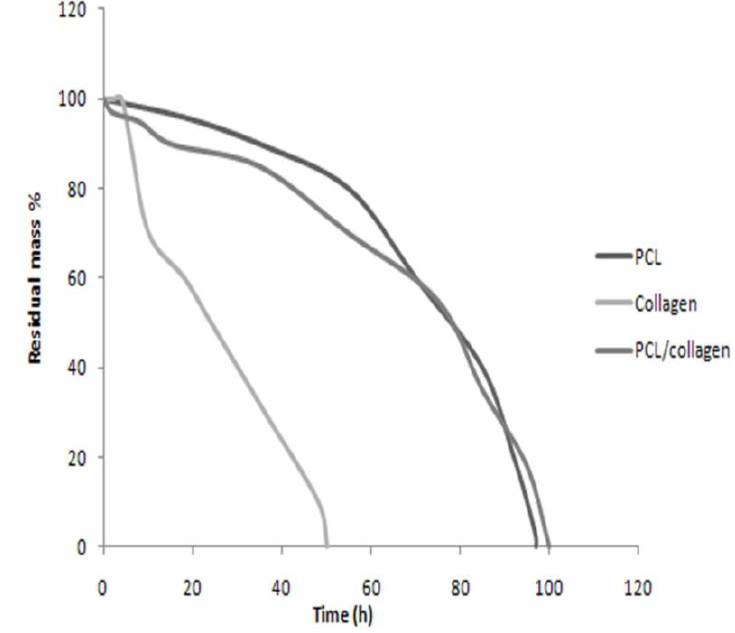
Figure 3. In vitro degradation behavior of electrospun scaffolds. PCL nanofibers resisted degradation for 96 hours, collagen nanofibers were resistant for 36 hours, and the biocomposite PCL/collagen nanofibers were resistant for 100